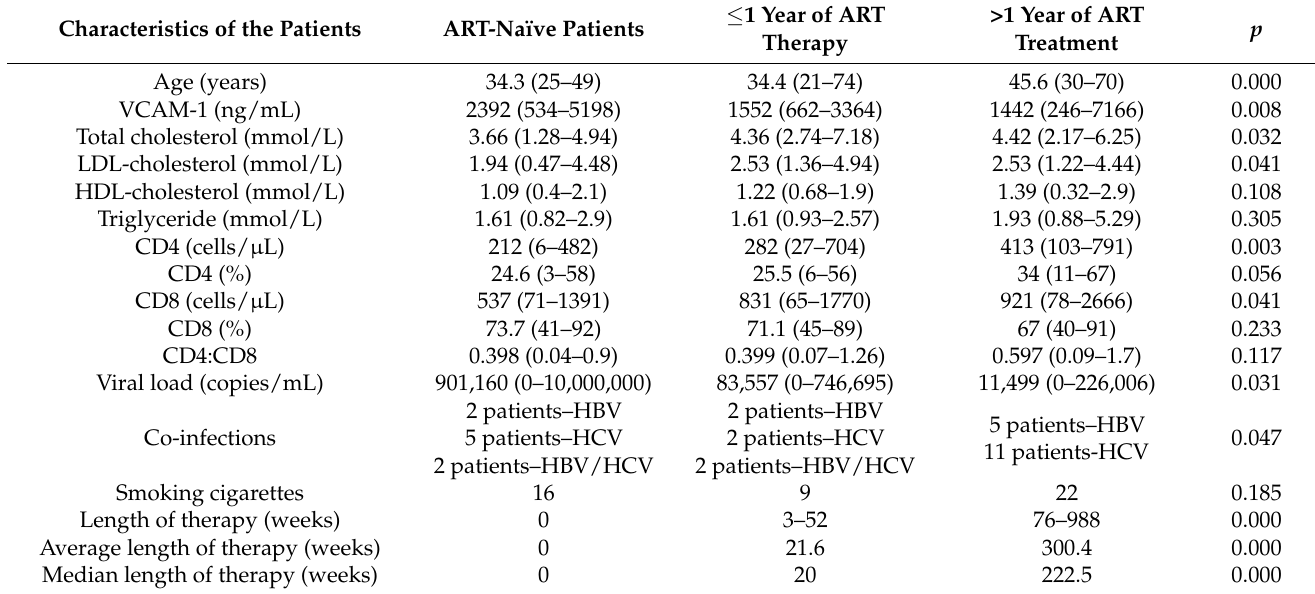
Table 1. Basic characteristics of the patients.